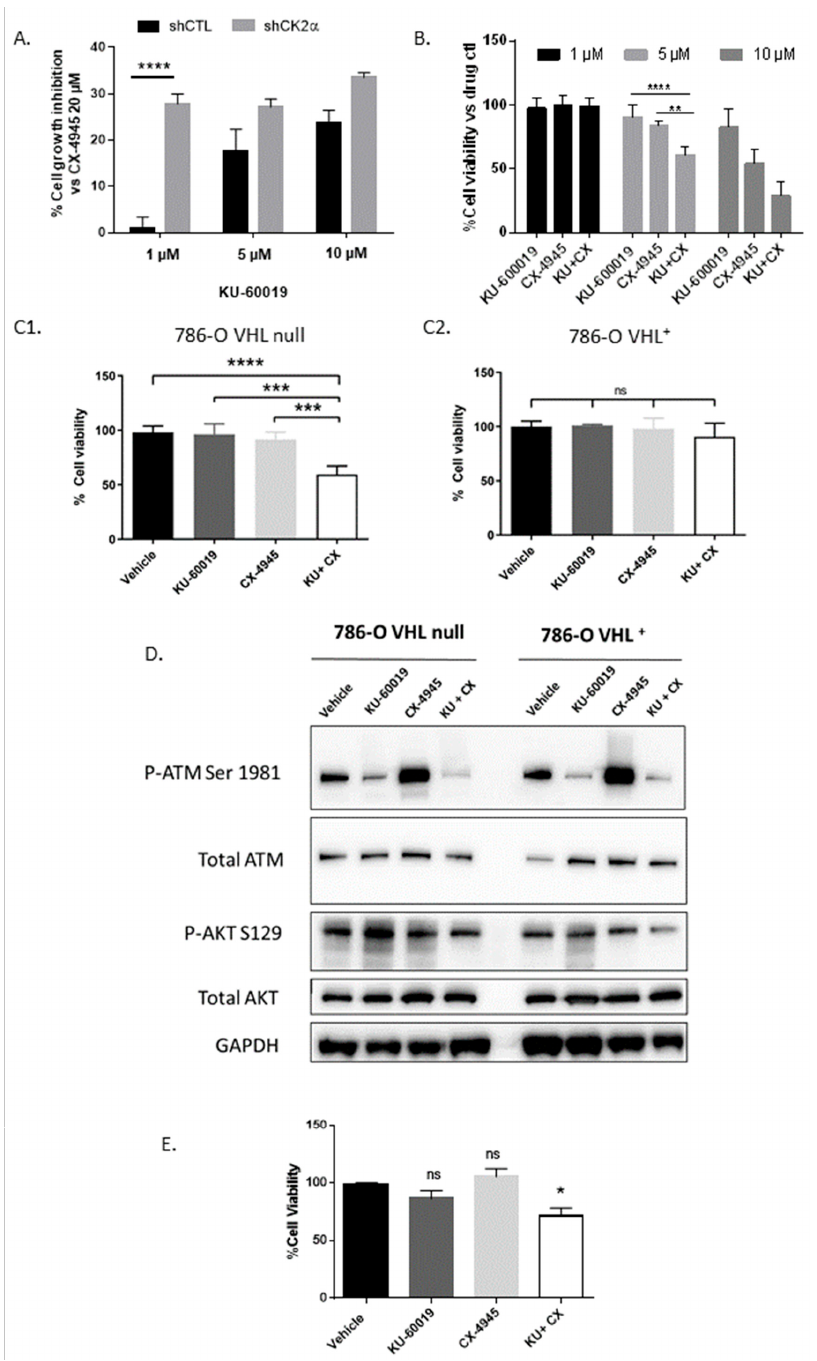
Figure 1. Co-Inhibition of CK2 α and ATM kinases induces enhanced cell toxicity in ccRCC cells. ( A ) shCTL and shCK2 α - transduced 786-O cells were treated with indicated concentrations of ATM inhibitor (KU-60019) for 48 h and cell viability was measured using Prestoblue ® assay ( n = 4). The 100% cell growth inhibition corresponds to cells treated with CX-4945 (20 µ M). ( B ) Relative sensitivity of 786-O cells to a dual drug inhibition of CK2 α (CX-4945) and ATM (KU-60019) kinases at different concentrations (1 µ M in black, 5 µ M in light grey and 10 µ M in dark grey) ( n = 6). ( C ) Relative sensitivity of 786-O cells without VHL ( C1 , n = 4) or with re-introduced VHL ( C2 , n = 4) to single drugs (KU-60019, 5 µ M, or CX-4945, 2.5 µ M) or drug combination, in hypoxic conditions (1.5% O 2 ). ( D ) Western blot analysis showing expression level of ATM, P-ATM (Ser1981), AKT, P-AKT (Ser129) and GAPDH as a loading control. ( E ) Relative sensitivity of CAKI-2 ccRCC cell line ( n = 4) to single drugs (KU-60019, 5 µ M, or CX-4945, 2.5 µ M) or drug combination in hypoxic conditions (1.5% O 2 ) compared to the Vehicle (DMSO). Two-way analysis of variance (ANOVA) and Mann–Whitney analysis were used for ( A ) and ( B – E ), respectively. * p < 0.05, ** p < 0.01, *** p < 0.001, **** p < 0.0001, ns (not